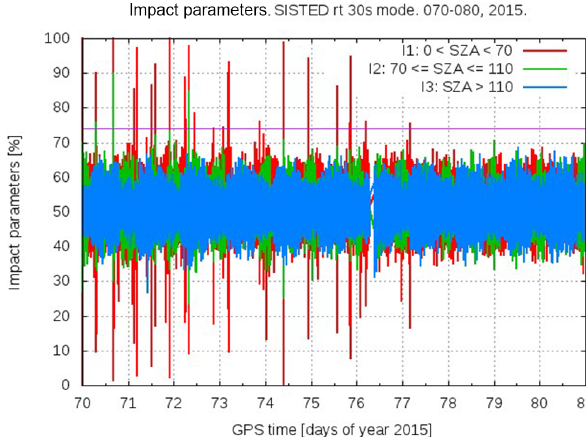
Figure 19. SISTED impact parameters evolution on days 70–80, 2015. The sunlit ionospheric region values are marked in red, the dawn and dusk values in green and the nighttime ones in